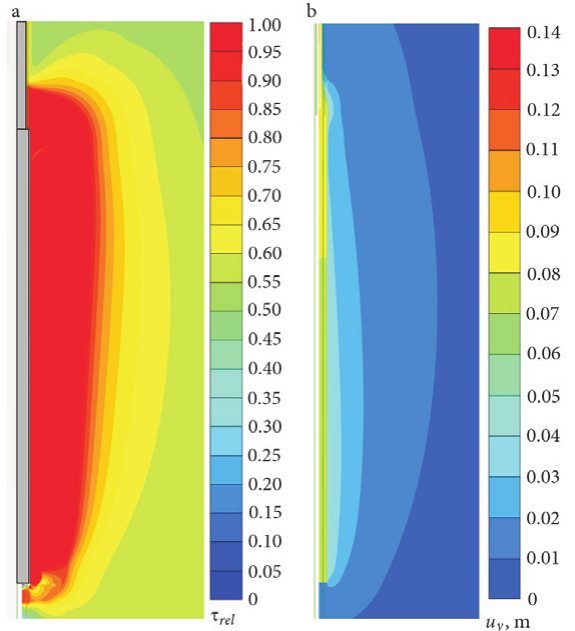
Fig. 14. Distribution of the relative shear stresses (a) and vertical displacement